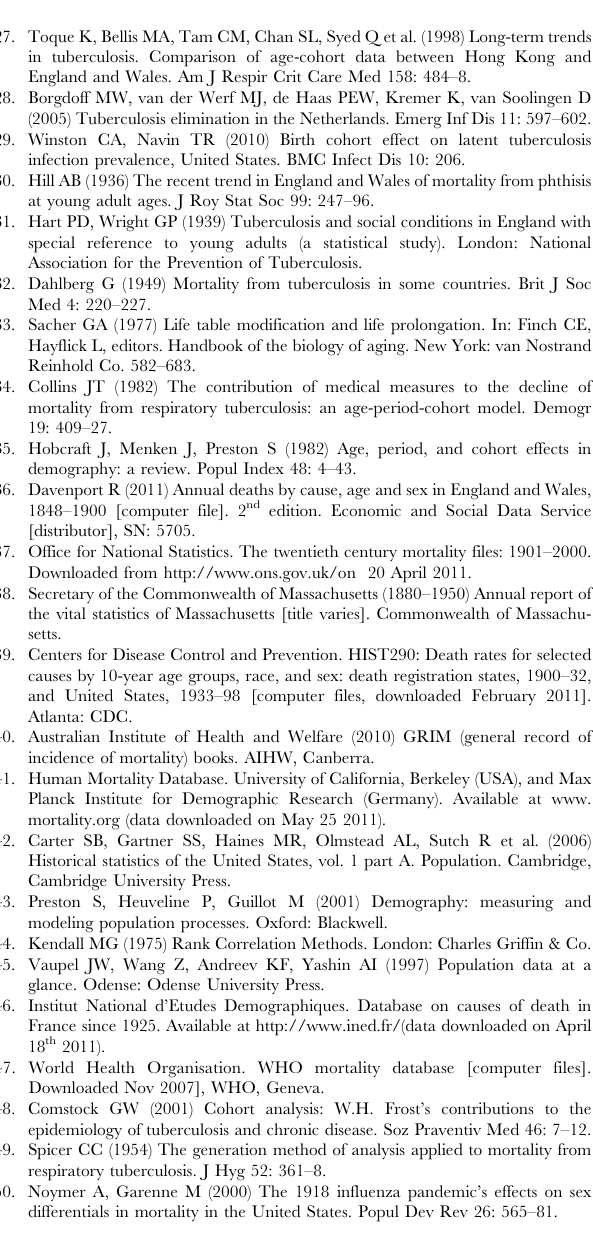
Figure S5 Quinquennial percentage improvement in age-specific respiratory tuberculosis mortality rates, Norway, 1871–1955. Colours represent the range in percentage annual change indicated by the scale. Diagonal lines represent birth cohorts. Vertical patterns indicate that rates of mortality improvement were similar across age groups in a given year; diagonal patterns indicate that rates of change were more consistent within birth cohorts than by period. (TIF) Data S1 Deaths registered from tuberculosis in